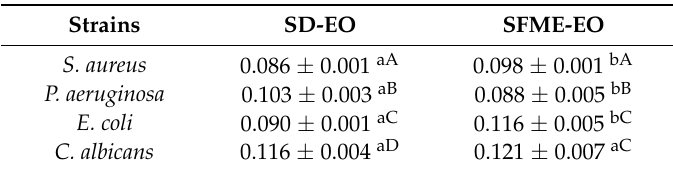
Table 3. Minimum inhibitory concentrations (MIC 90 ) (%, v / v ) for the antimicrobial activity of ‘Mato Peiyu’ leaf essential